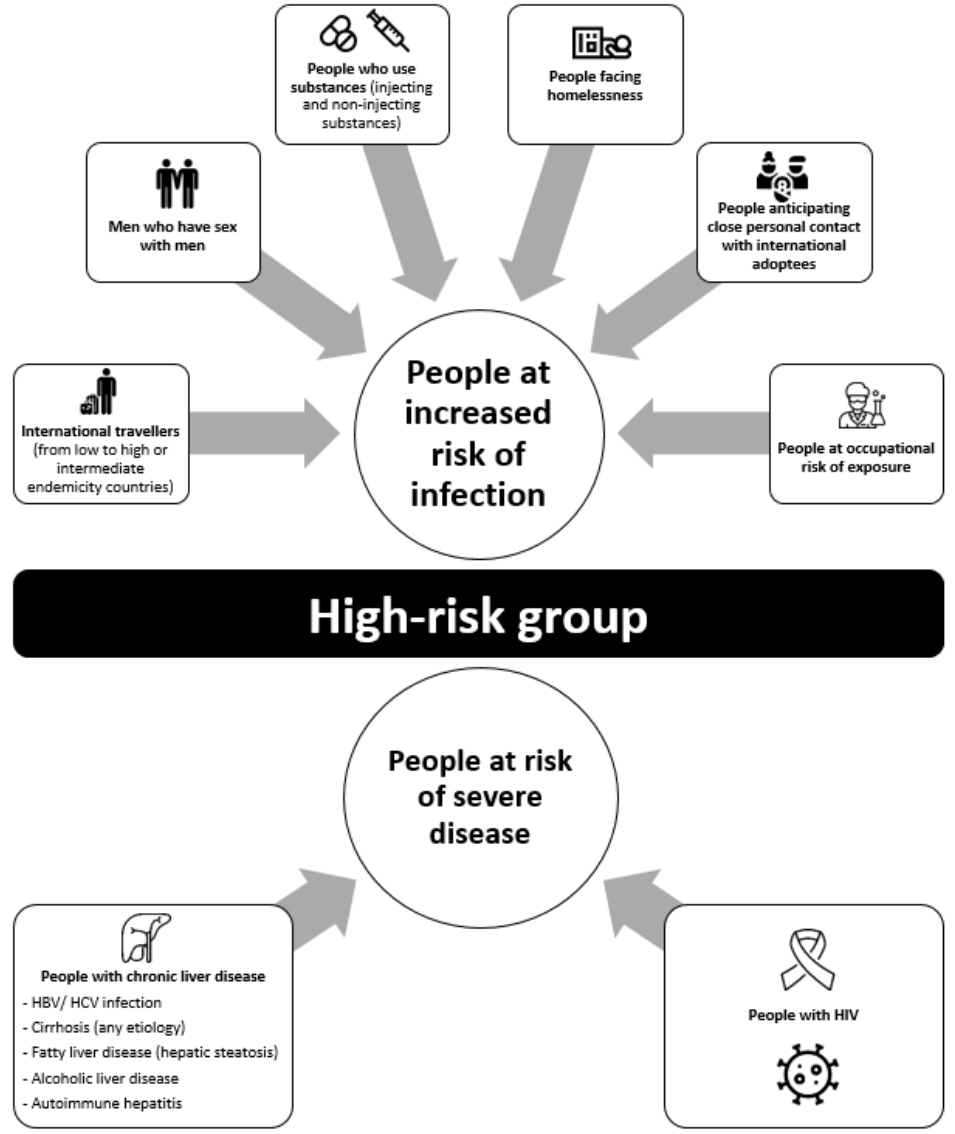
Figure 1. High-risk group vaccination recommendations [24].